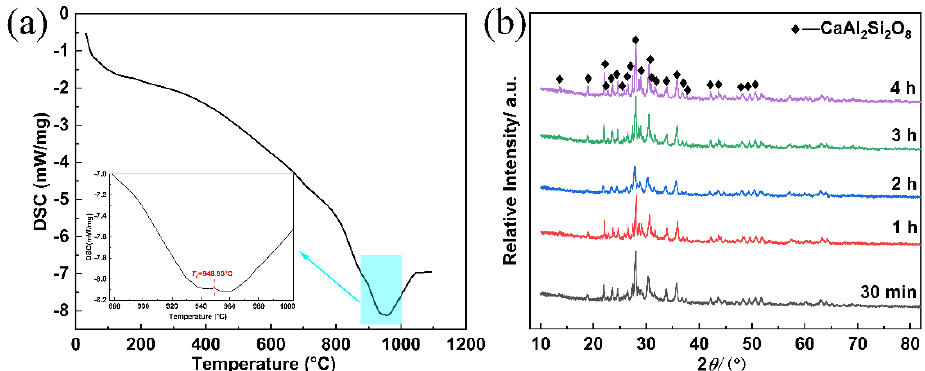
Figure 8. The crystallization temperature ( a ) of parent glass obtained from smelting slag after water cooling, and the XRD phases ( b ) of prepared glass-ceramics at different heat-treatment